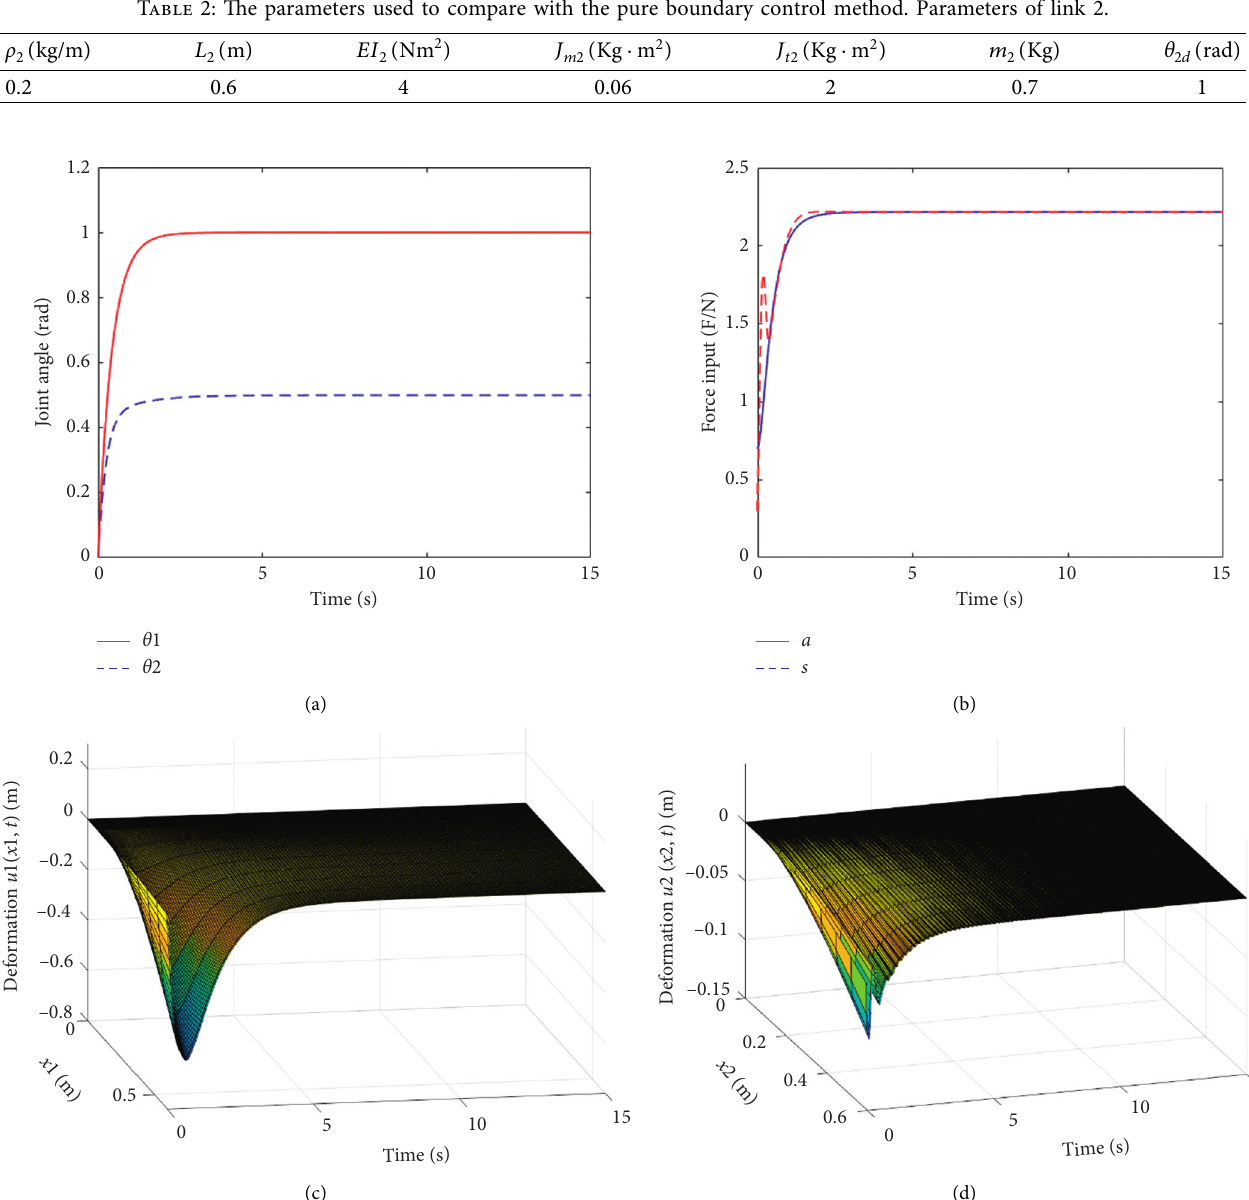
Table 2: The parameters used to compare with the pure boundary control method. Parameters of link